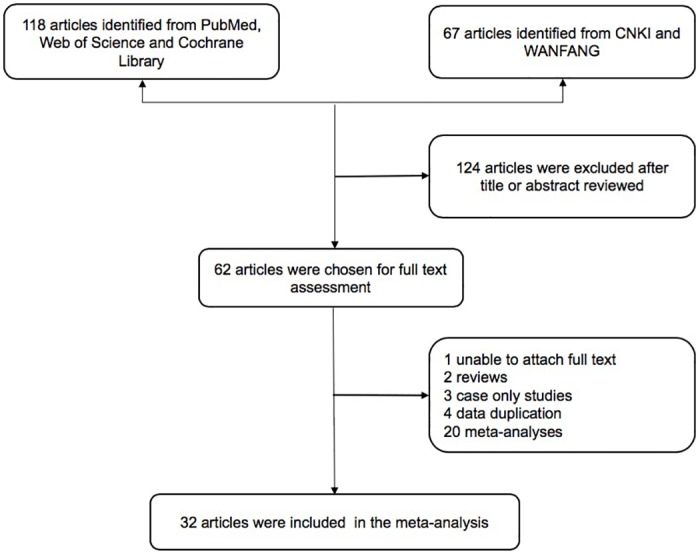
Flow diagram of study selection for the meta-analysis.CNKI, Chinese National Knowledge Infrastructure Database. WFSD, the Wanfang standard database.